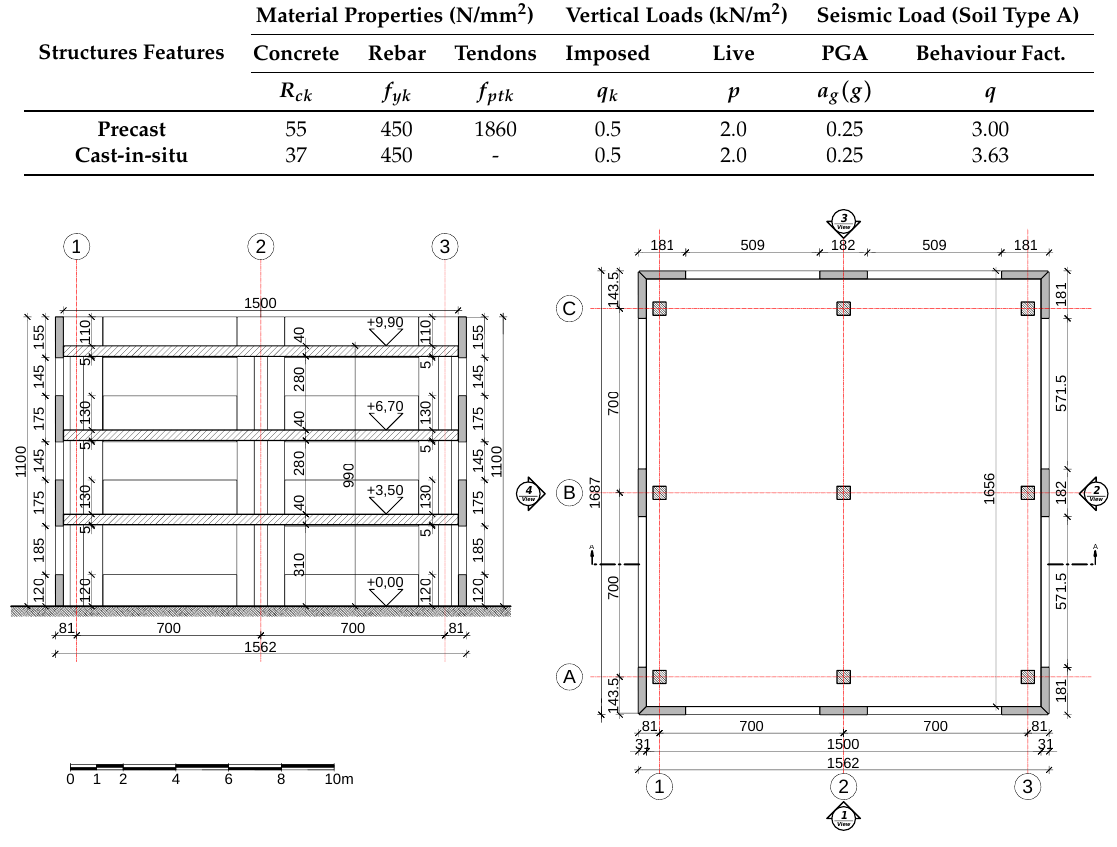
Figure 5. General plan of the